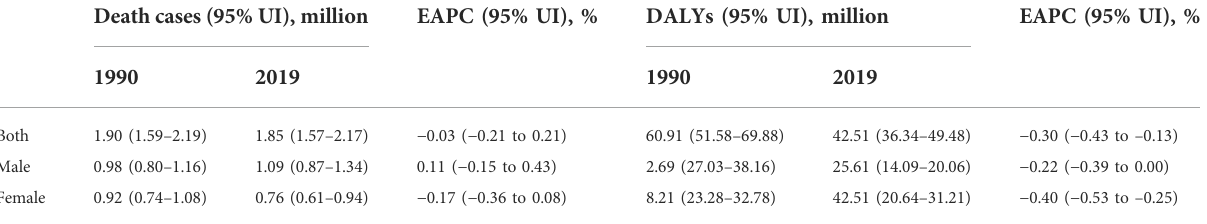
TABLE 1 Deaths and DALYs attributable to air pollution in China in 1990 and 2019.